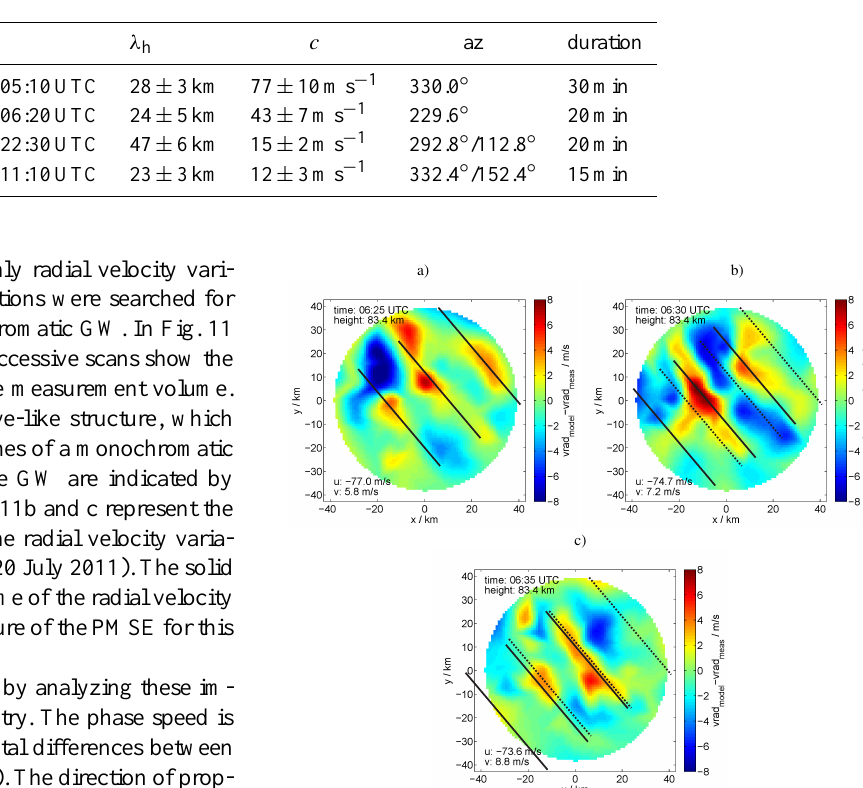
Table 3. Determined gravity wave parameters estimated from the radial wind variation images. Here c denotes the intrinsic phase speed, λ h the horizontal wavelength and “az” the azimuth angle of the propagation direction.